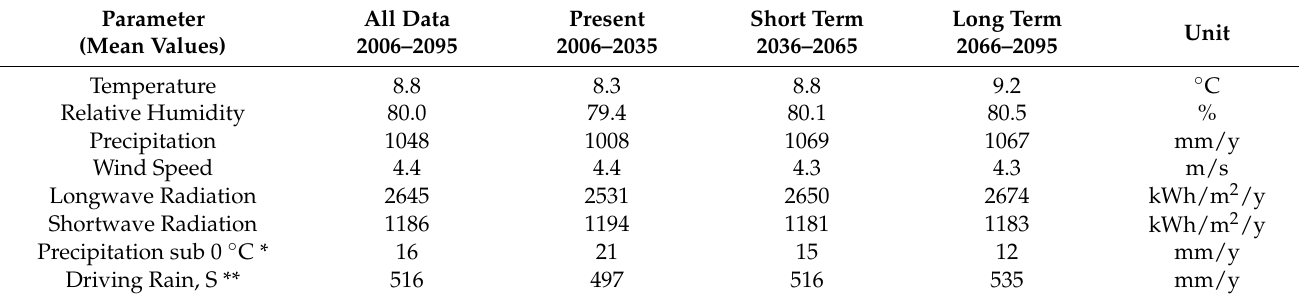
Table 5. Climatic data used in the simulations for Gothenburg 2006–2096 based on [27,28]. Precipitation sub 0 ◦ C and driving rain were calculated from wind speed, wind direction, precipitation and temperature.